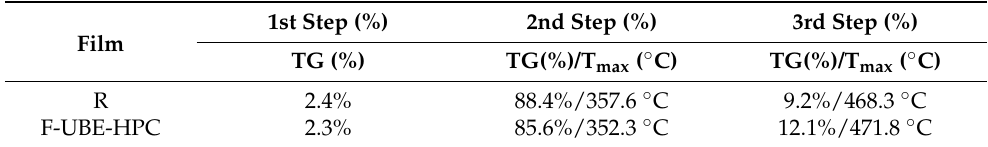
Table 2. Thermal data of the studied samples.